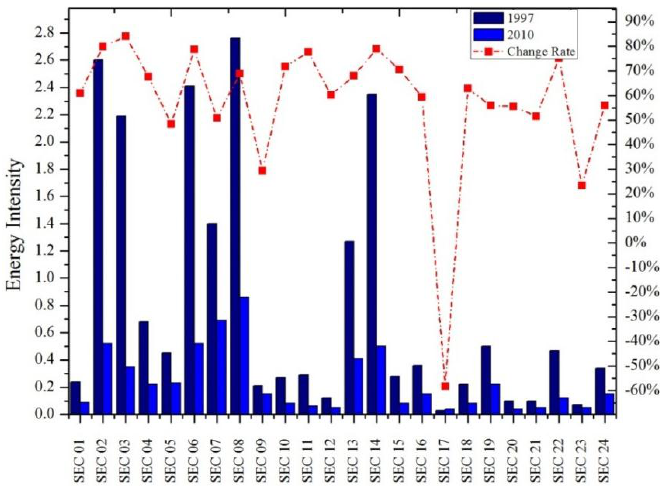
Figure 2. The energy intensities of 24 sectors.